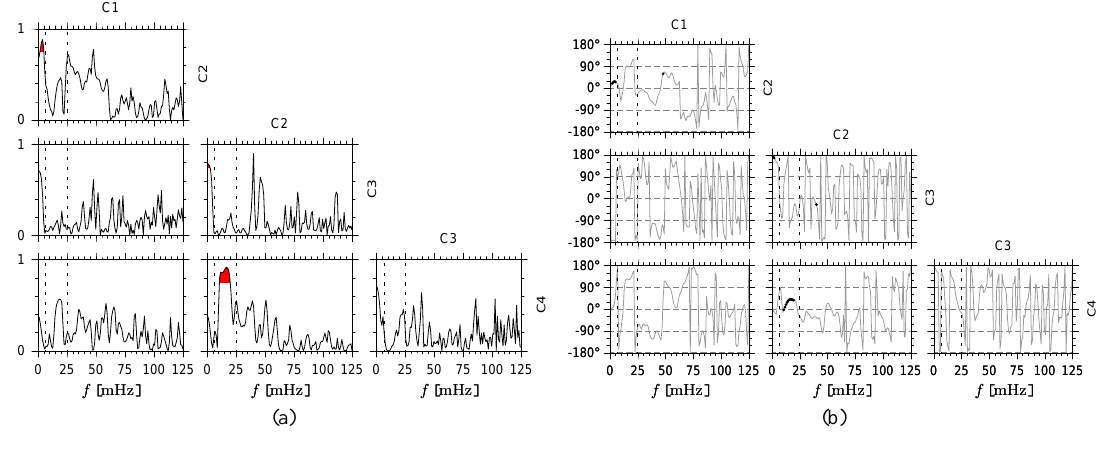
Fig. 12: Inter-satellite (a) coherence and (b) phase for the azimuthal component of the magnetic field, b φ . Pi2 event, and concluded that this was evidence of a radial standing wave. Keiling et al. (2001) documented evidence of simultaneous standing poloidal and toroidal waves during a Pi2 event observed on